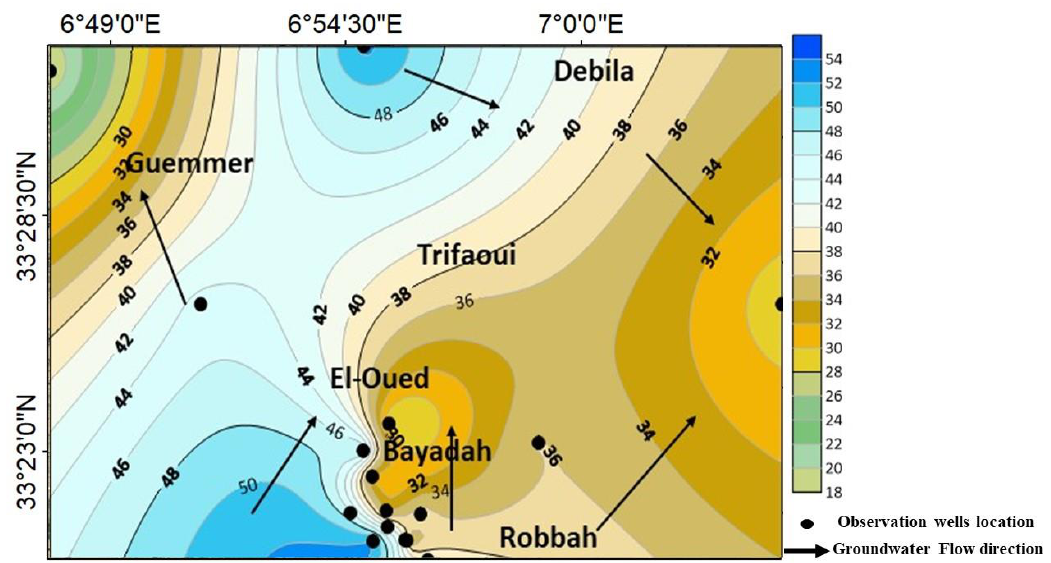
Figure 2. Hydrogeological cross-section of the CT aquifer [44,46,47].